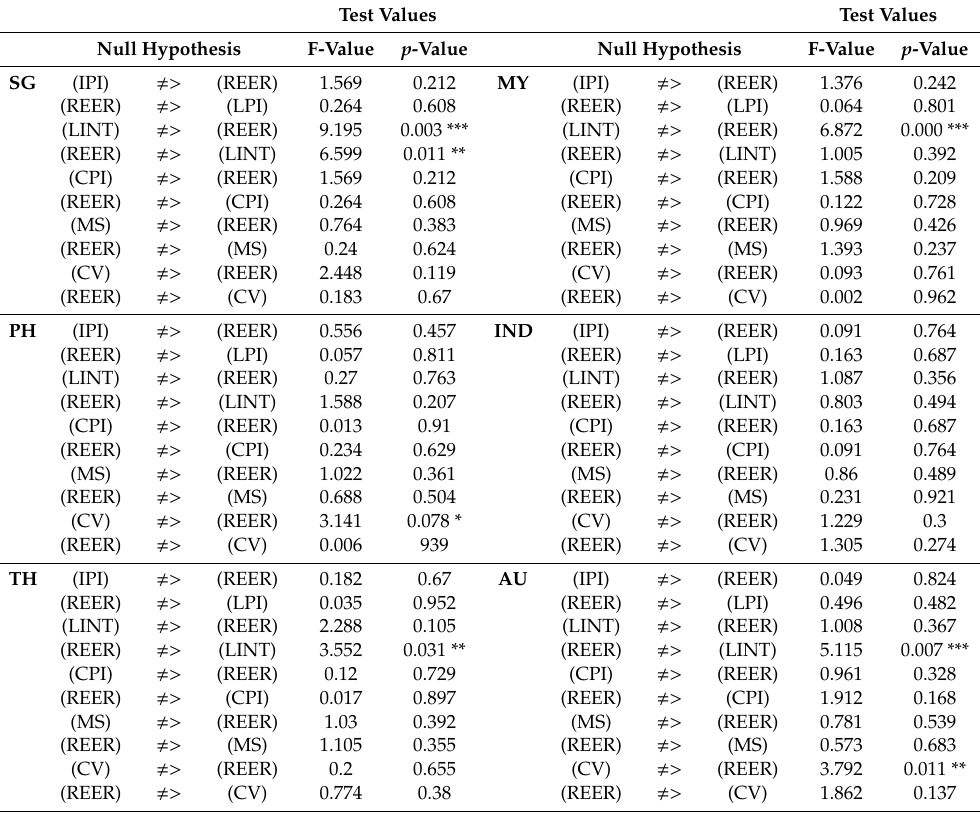
Table 7. Pairwise linear Granger-causality test between REERs and China’s macroeconomic variables: January 1998–December